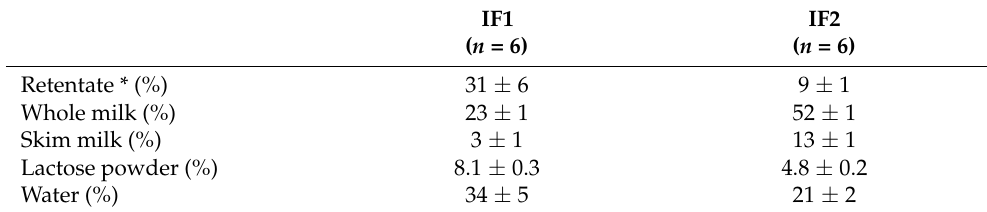
Table 2. Relative incidence of the ingredients utilized in the preparation of the liquid milk-derived formulations IF1 and IF2, to be used in the production of first stage (from 0 to 6 months of age) and follow-on (from 6 to 12 months of age) infant formulae, respectively (mean ± SD). IF1 IF2 ( n = 6) ( n = 6) Retentate * (%) 31 ± 6 9 ± 1 Whole milk (%) 23 ± 1 52 ± 1 Skim milk (%) 3 ± 1 13 ± 1 Lactose powder